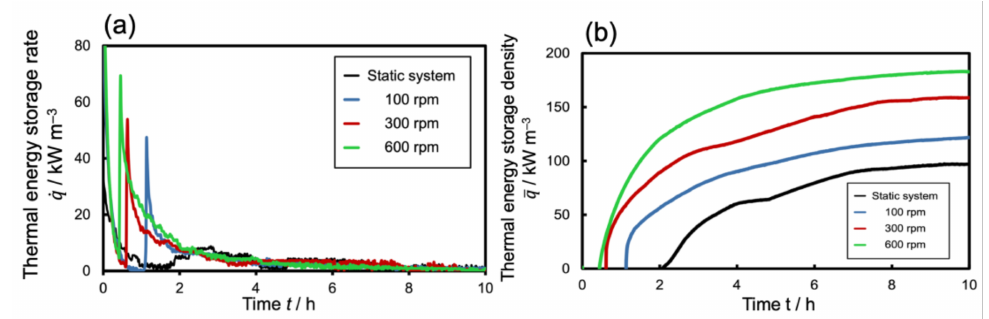
Figure 8. Time evolution of thermal energy storage rate and density in the agitated system ( a , b ) depict the thermal energy storage rate and density,